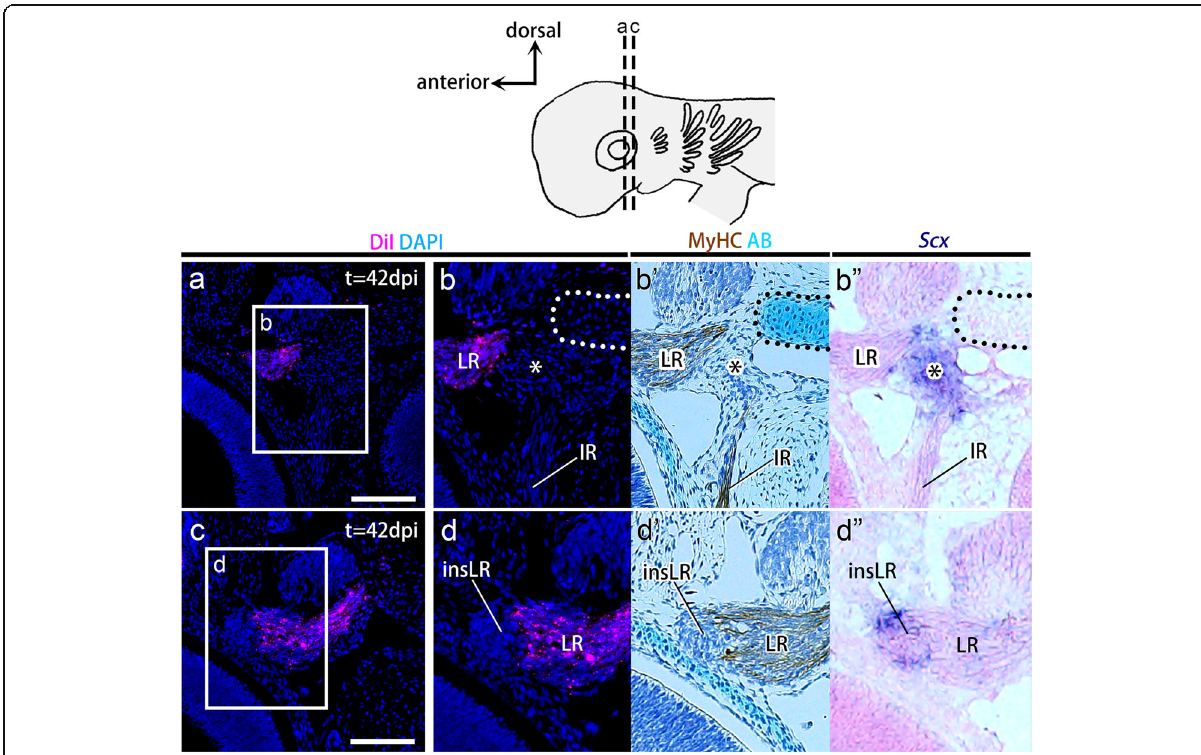
Fig. 4 Lineage tracing of the hyoid head cavities. a-d ″ Transverse sections of CM-DiI-injected embryos aligned with adjacent sections immunostained with myosin heavy chain antibody ( b ′ and d ′ ), stained with Alcian blue (AB) ( b ′ and d ′ ), and hybridized in situ with a Scx antisense RNA probe ( b ″ and d ″ ). By 42 dpi, CM-DiI-labeled cells (magenta) were found in the lateral rectus muscle but not in Scx -positive tendon progenitor cells at the origin of all rectus muscles (asterisks), the insertion site of the lateral rectus muscle (insLR), or the skeleton at the attachment sites of the rectus muscles (pila antotica; outlined by the dotted line). insLR, tendon progenitor cells at the insertion site of the lateral rectus muscle; IR, inferior rectus muscle; LR, lateral rectus muscle. Scale bars = 200 μ